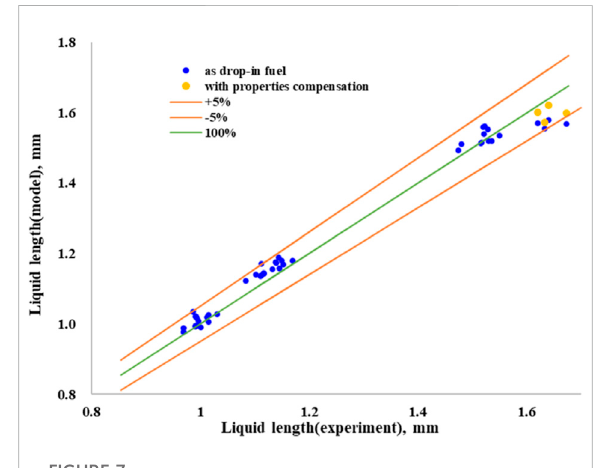
FIGURE 6 Cone angle predicting the model performance. FIGURE 7